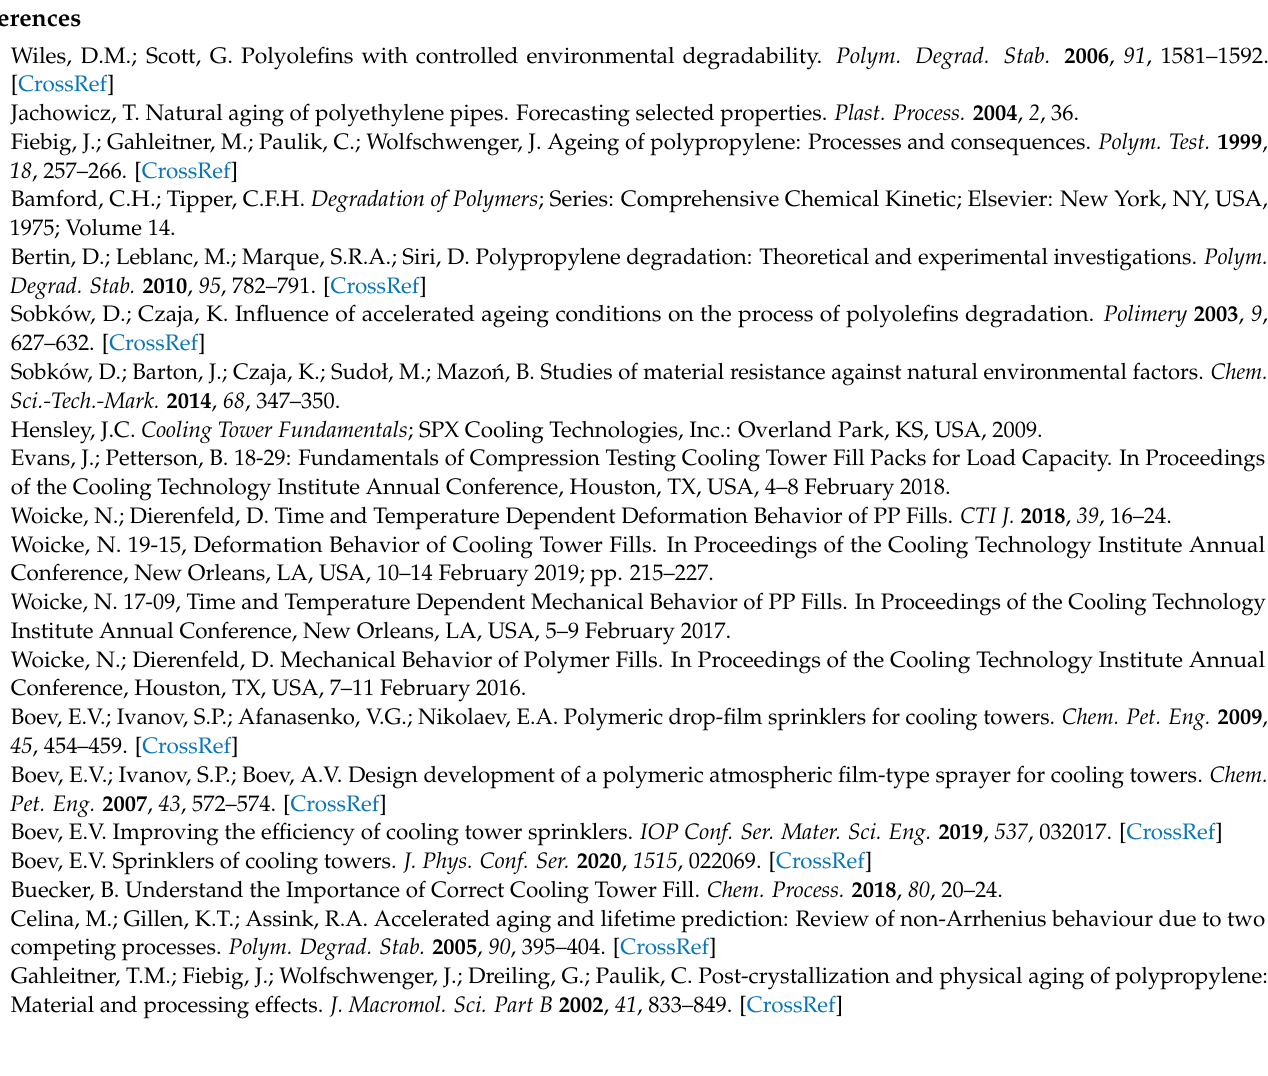
Figure S3: CT1_RS spectrum; Figure S4: The spectrum of CT2_C2; Figure S5: CT2_RS spectrum; Figure S6: Dependence of sample mass on temperature increasing with constant velocity in the TGA CT1_LS tests; Figure S7: Dependence of sample mass on temperature increasing with constant velocity in the TGA CT1_C tests; Figure S8: Dependence of the sample mass on the temperature increasing with a constant speed in the TGA CT1_RS tests; Figure S9: Dependence of sample mass on temperature increasing with constant velocity in TGA CT2_C tests; Figure S10: Dependence of sample mass on temperature increasing with constant velocity in TGA CT2_RS